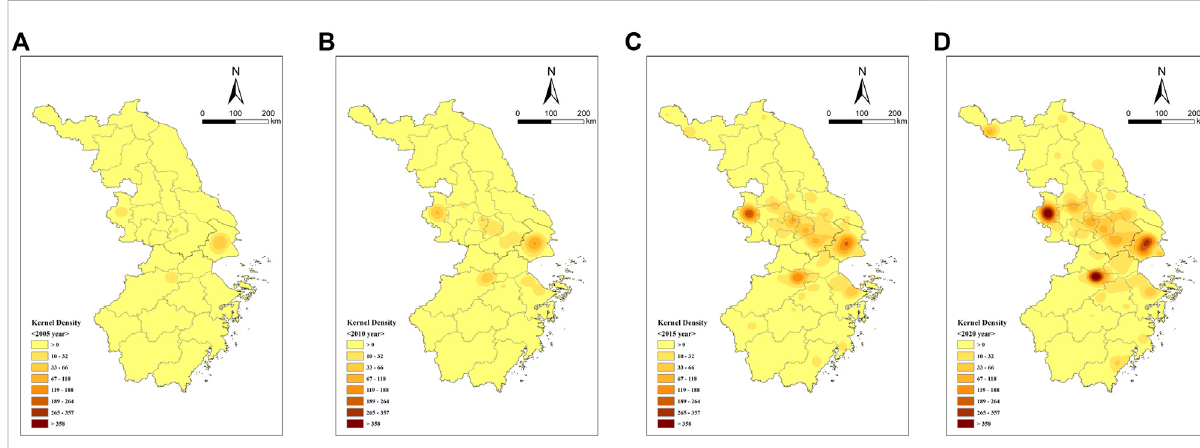
FIGURE 1 Kernel density of CHP technological innovation in 2005 (A) , 2010 (B) , 2015 (C) and 2020 (D)